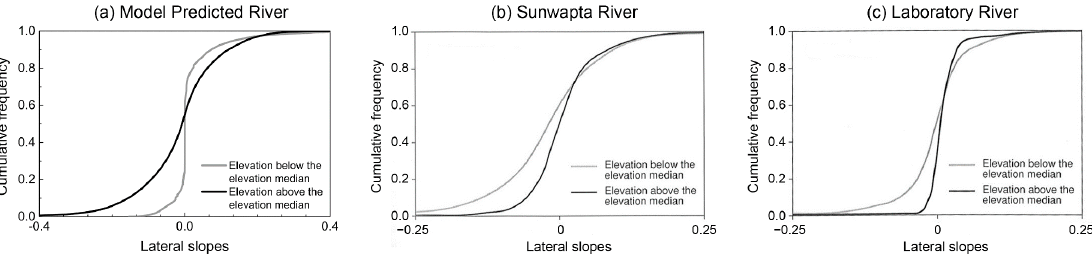
Figure 12. Cumulative distributions of the lateral slopes of the bars and channels for ( a ) the model predicted river; ( b ) the Sunwapta River; and ( c ) a laboratory river.